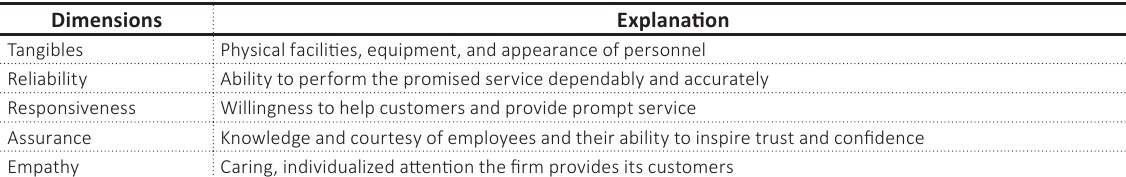
Source: Parasuraman, Zeithaml, and Berry (1988).